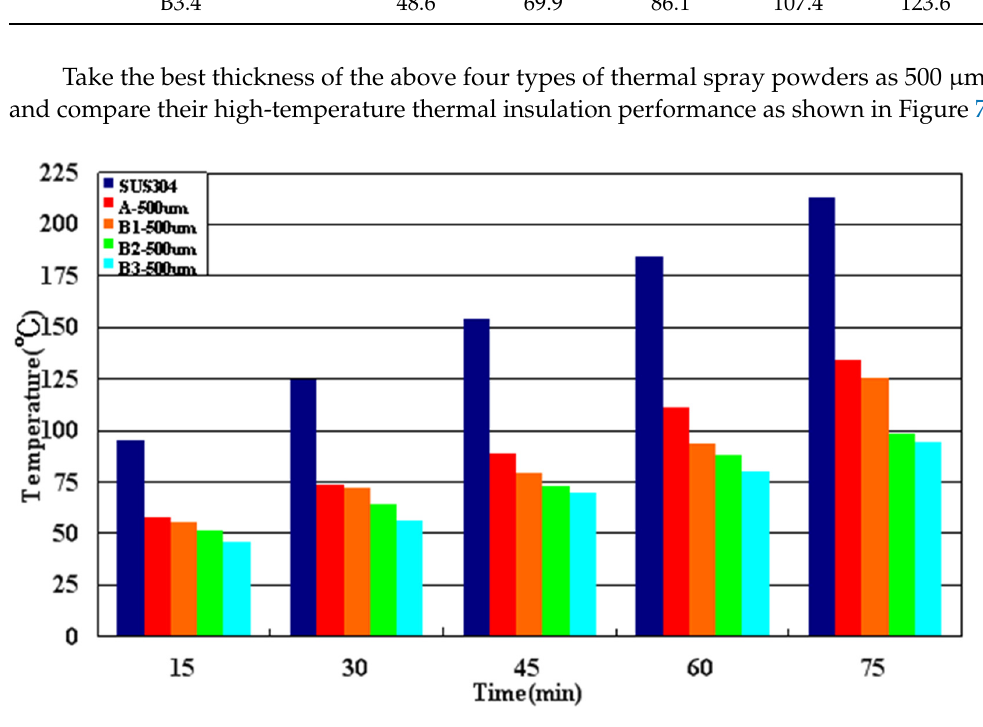
Figure 7. The temperature change analysis diagram of the center point of the SUS304 surface and the coating surface of 500 μ m A and